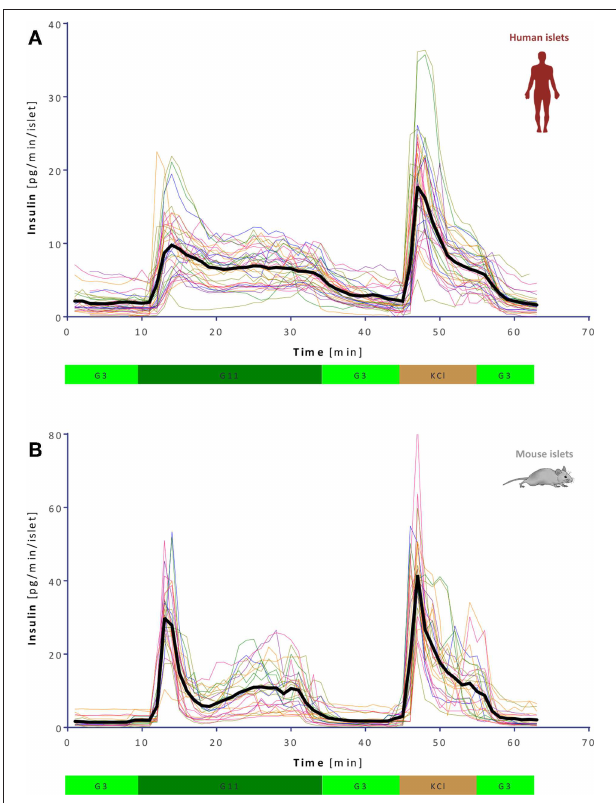
FIGURE 2 | Variability of dynamic GSIS in isolated human and mouse islets. All experimental data for human (A) and mouse (B) islets perifused as before (G3 → G11 → G3 → KCl, see Figure 1 ) shown together with their overall average (thick black line; n = 34 and 25,